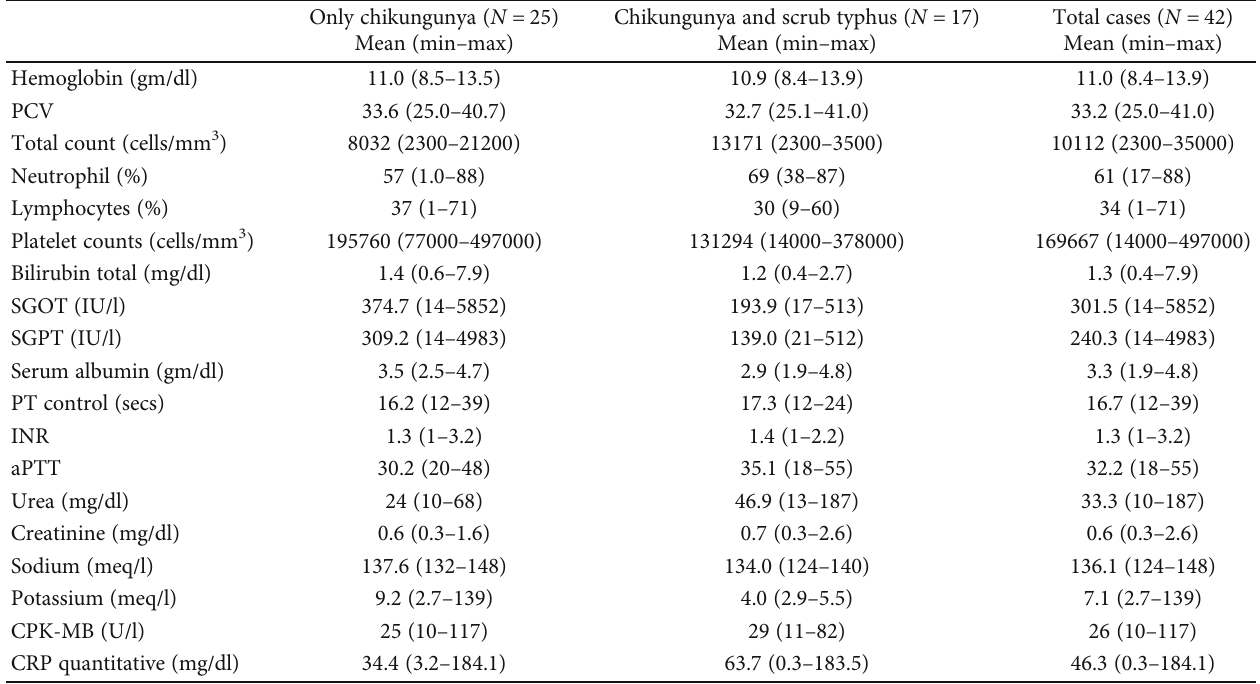
Table 3: Clinicolaboratory